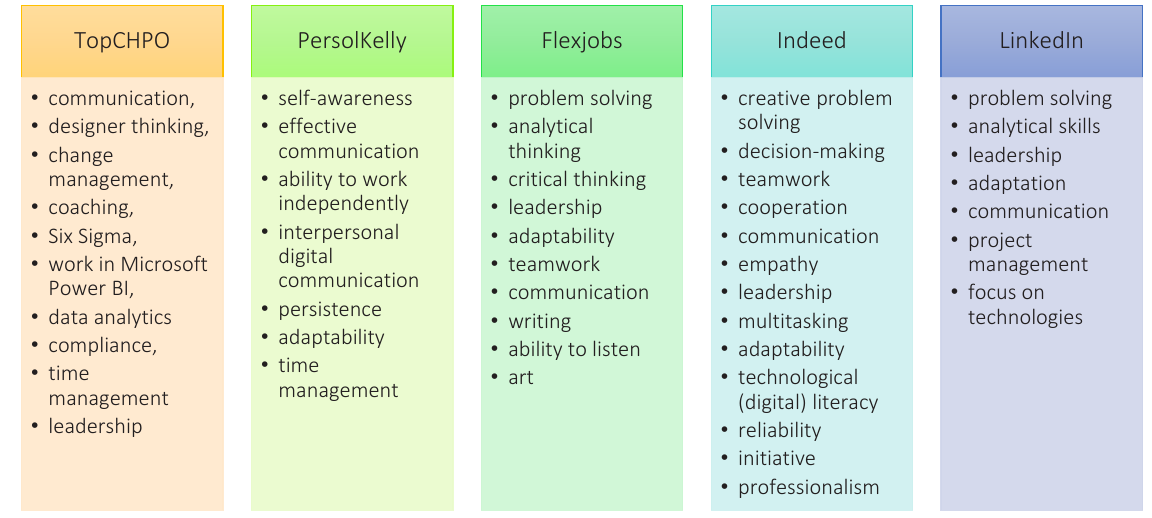
Figure 1. Transferable competencies, which are in demand on the world labor market